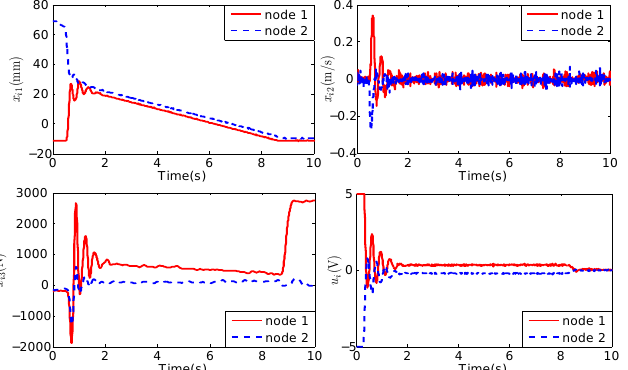
Figure 10. The MEHAs’ state responses with two nodes in the experiment: x i 1 —the cylinder position; x i 2 —the cylinder velocity; x i 3 —the cylinder load pressure; u i —the control voltage of the servo valve.